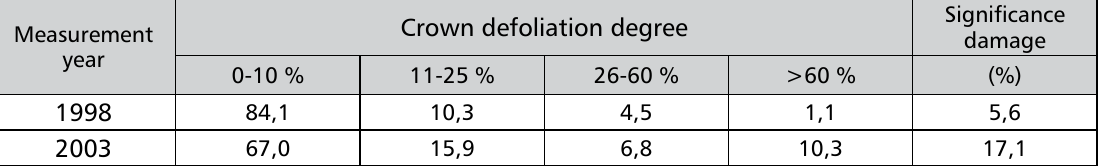
Crown damage of a common beech on the monitored plot